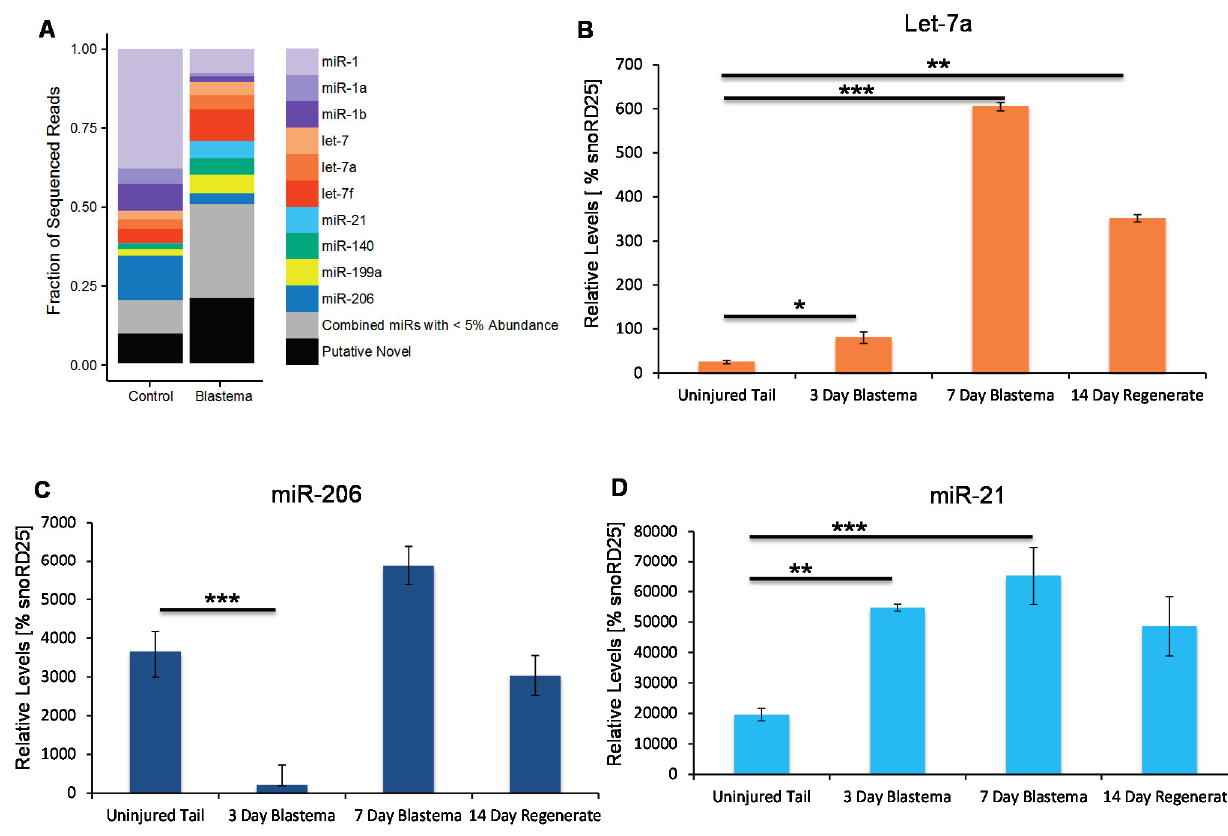
Figure 1. Deep sequencing of axolotl microRNAs. ( A ) Distribution of known and putative novel microRNA sequences in control tissue verses the three-day blastema. The fraction of reads that map to a known microRNA is shown for those microRNAs with at least 5% of the total number of sequenced reads. MicroRNAs present at less than 5% the total number of reads were collapsed into one category (gray portion). Putative novel microRNAs that did not map to mirBase 21 are also included in the total number of reads (black